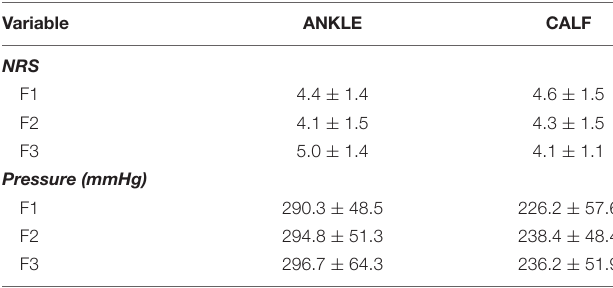
TABLE 2 | Descriptive statistics (mean ± SD).